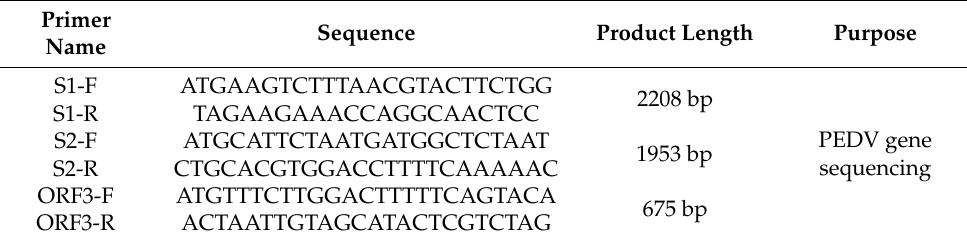
Table 3. Primers for PEDV S gene and ORF3 gene